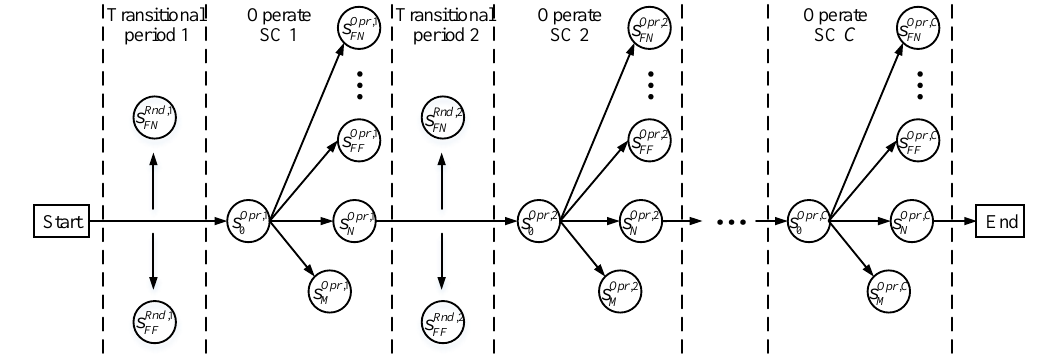
Figure 5. The transitions of grid states in the dispatching process.